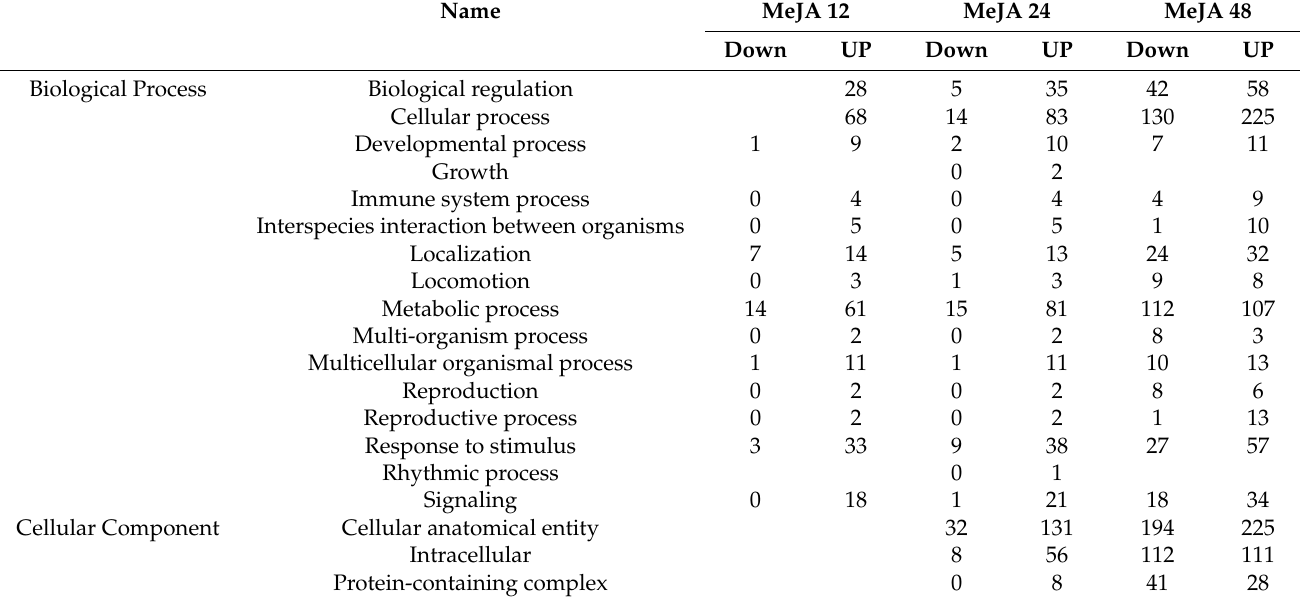
Table 2. Functional categorization of up- and downregulated genes after treatments with